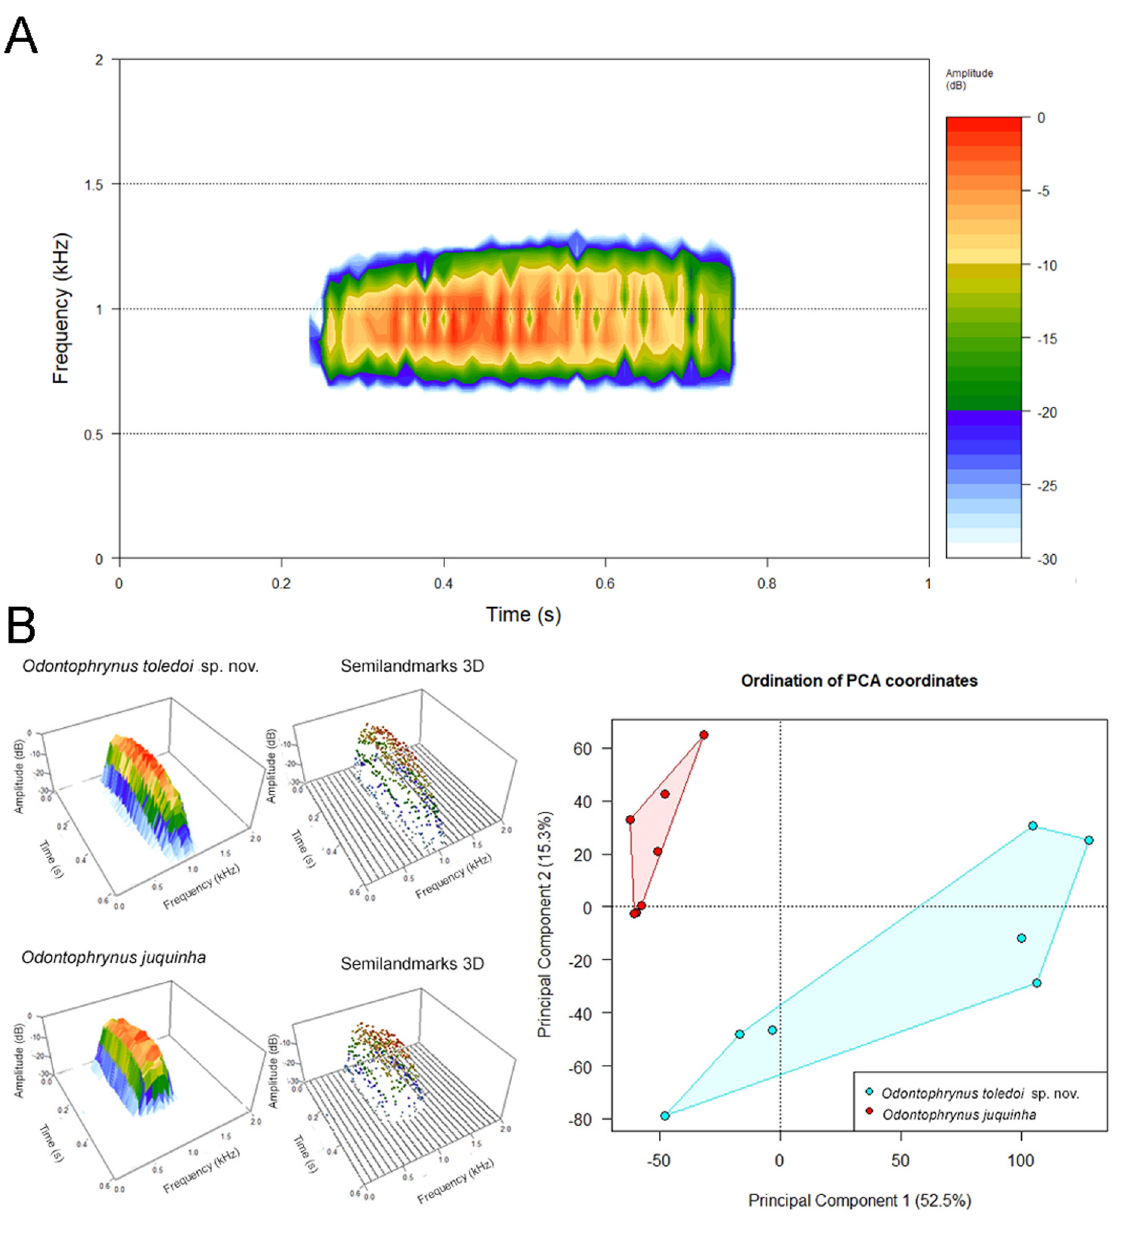
Fig. 7. A . Advertisement call of Odontophrynus toledoi sp. nov. B . Acoustic-space of Odontophrynus toledoi sp. nov. and Odontophrynus juquinha Rocha, Sena, Pezzuti, Leite, Svartman, Rosset, Baldo & Garcia, 2017, and the respective grid with the position of each semilandmark. The positions of the semilandmarks were obtained in the 3D spectrogram and summarized in a Principal Coordinate Analysis (PCA). With this, the ordering graphic recovered 73.8% of all the acoustic-space variance in the first two PCA axes, resulting in a non-overlapping of the acoustic-space of the two